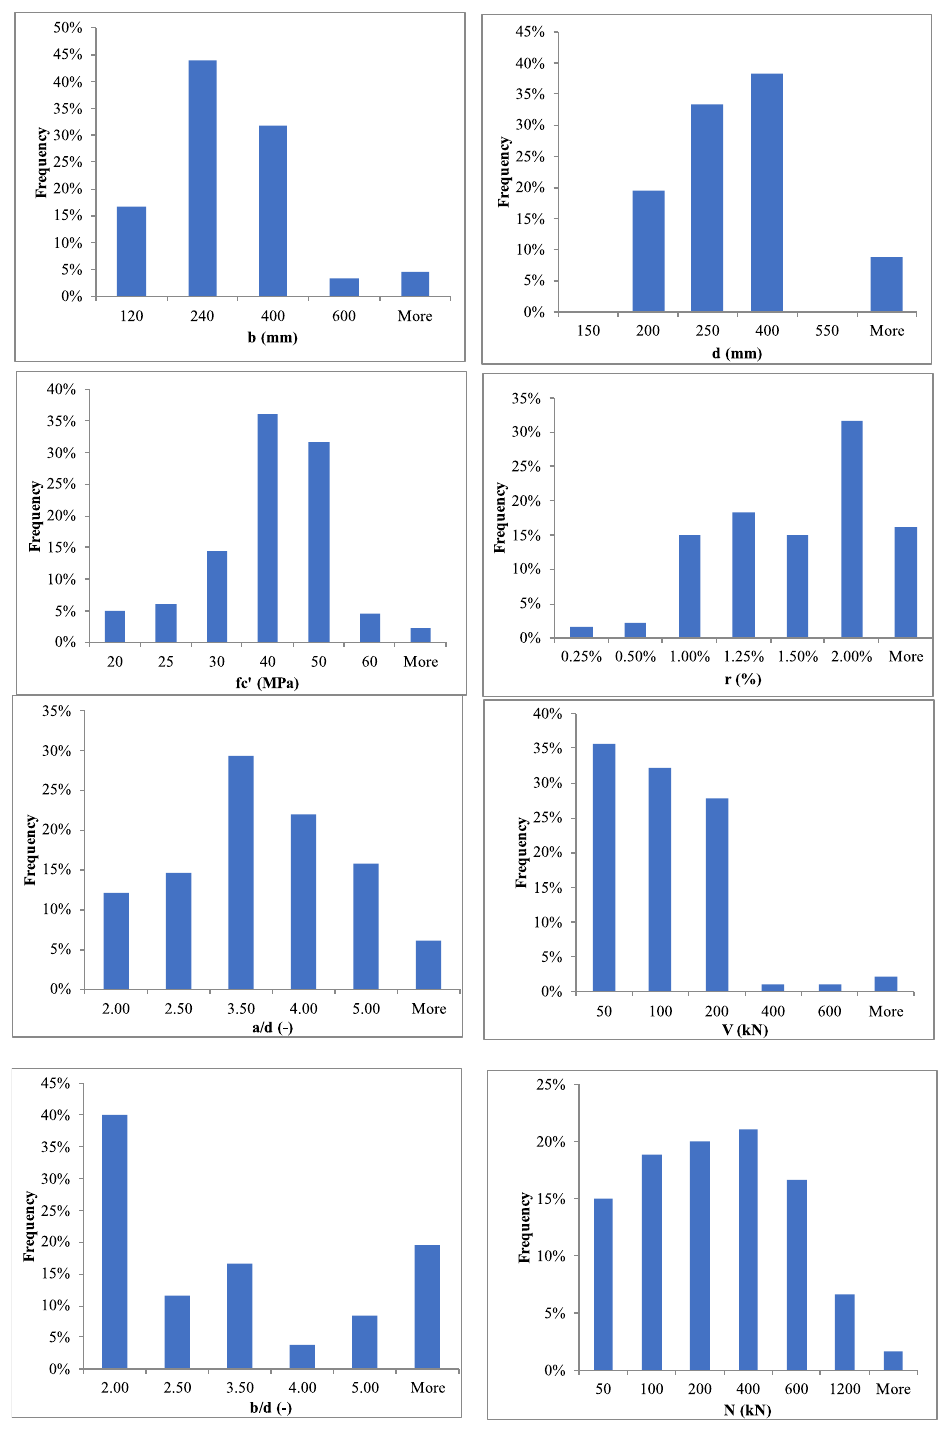
Figure 3. The profile of data